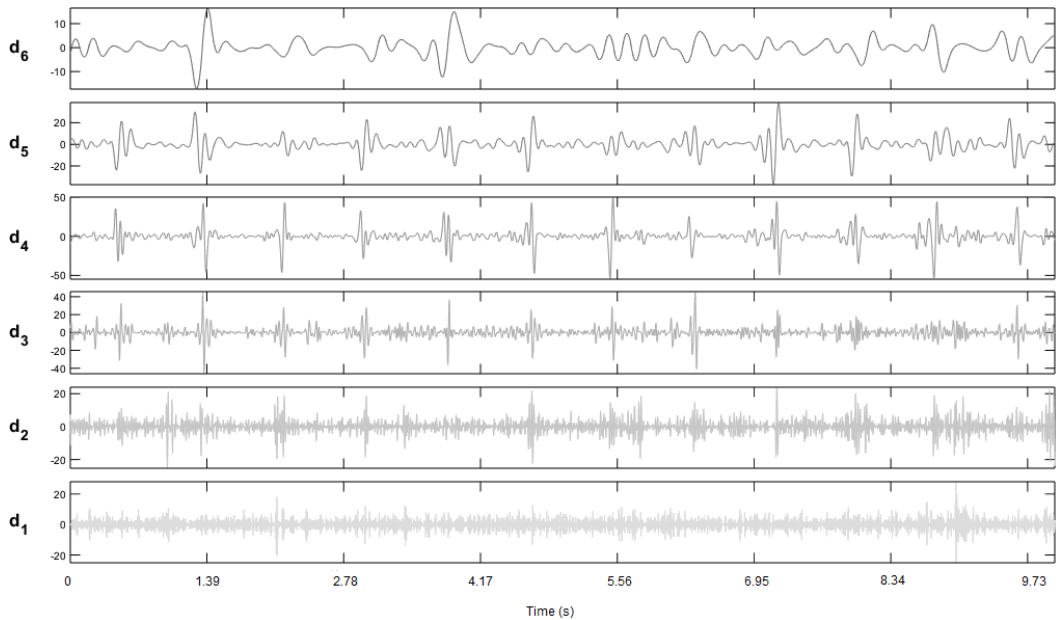
Figure 4. Decomposition of Hilbert signal over six dyadic scales.